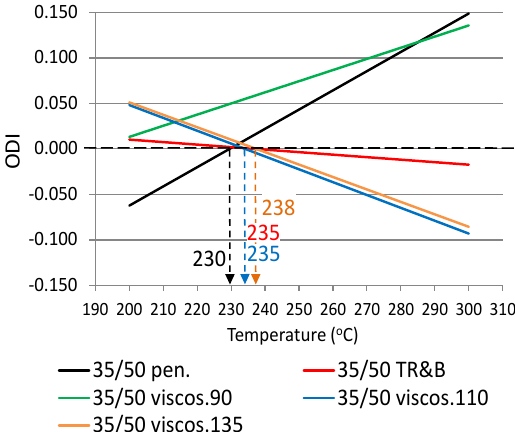
Figure 3. Overheating Degradation Index for binder 50/70 and determination of temperature T (ODI) .